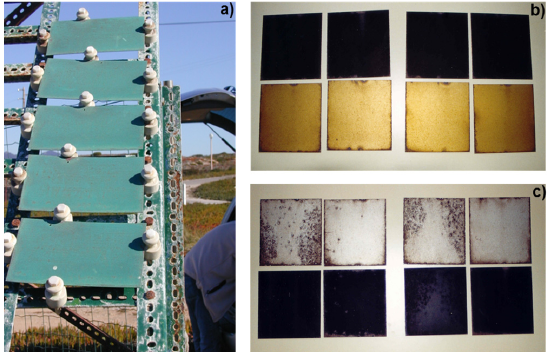
Figure 2. ( a ) In situ studies of coatings for steel protection in a marine environment; ( b , c ) anodized aluminium specimens after exposure in a natural industrial environment.